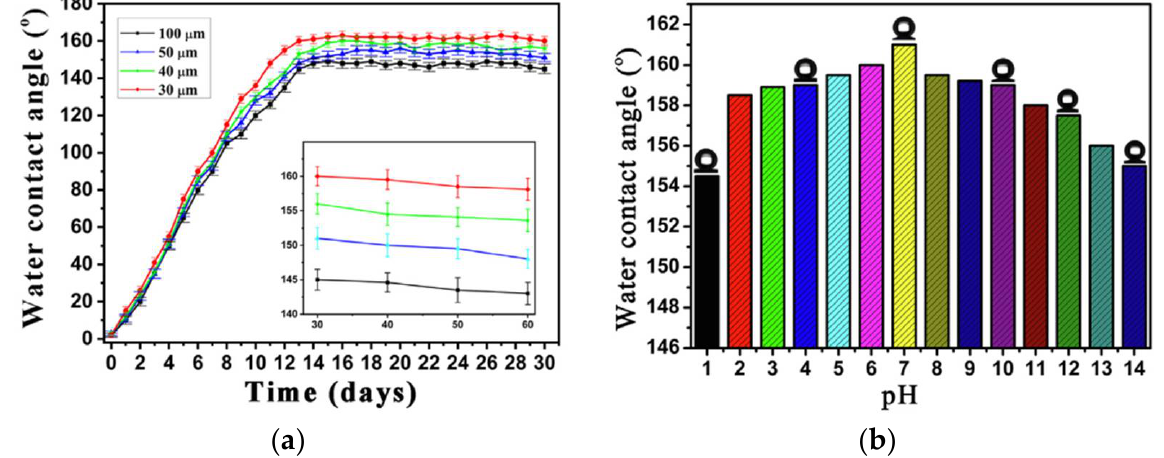
Figure 5. ( a ) Water contact angle for the time. ( b ) Water contact angle with different pH values. Reprinted with permission from Ref [53]. Copyright 2020 Elsevier.